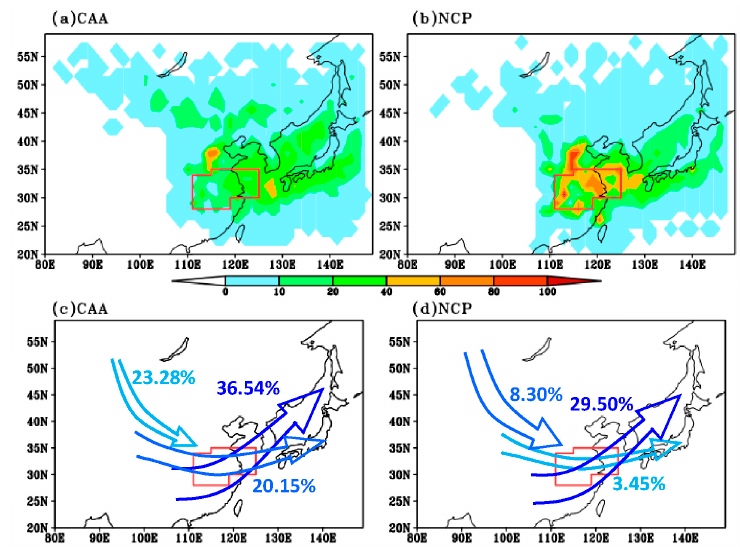
Figure 1. The density of influential cyclone (IC) tracks (number of tracks for each grid point) ( a,b ) and frequency of the three main high-frequency tracks ( c,d ). The left panel is for the cyclone area algorithm (CAA), and the right panel is for the neighbor center point (NCP).